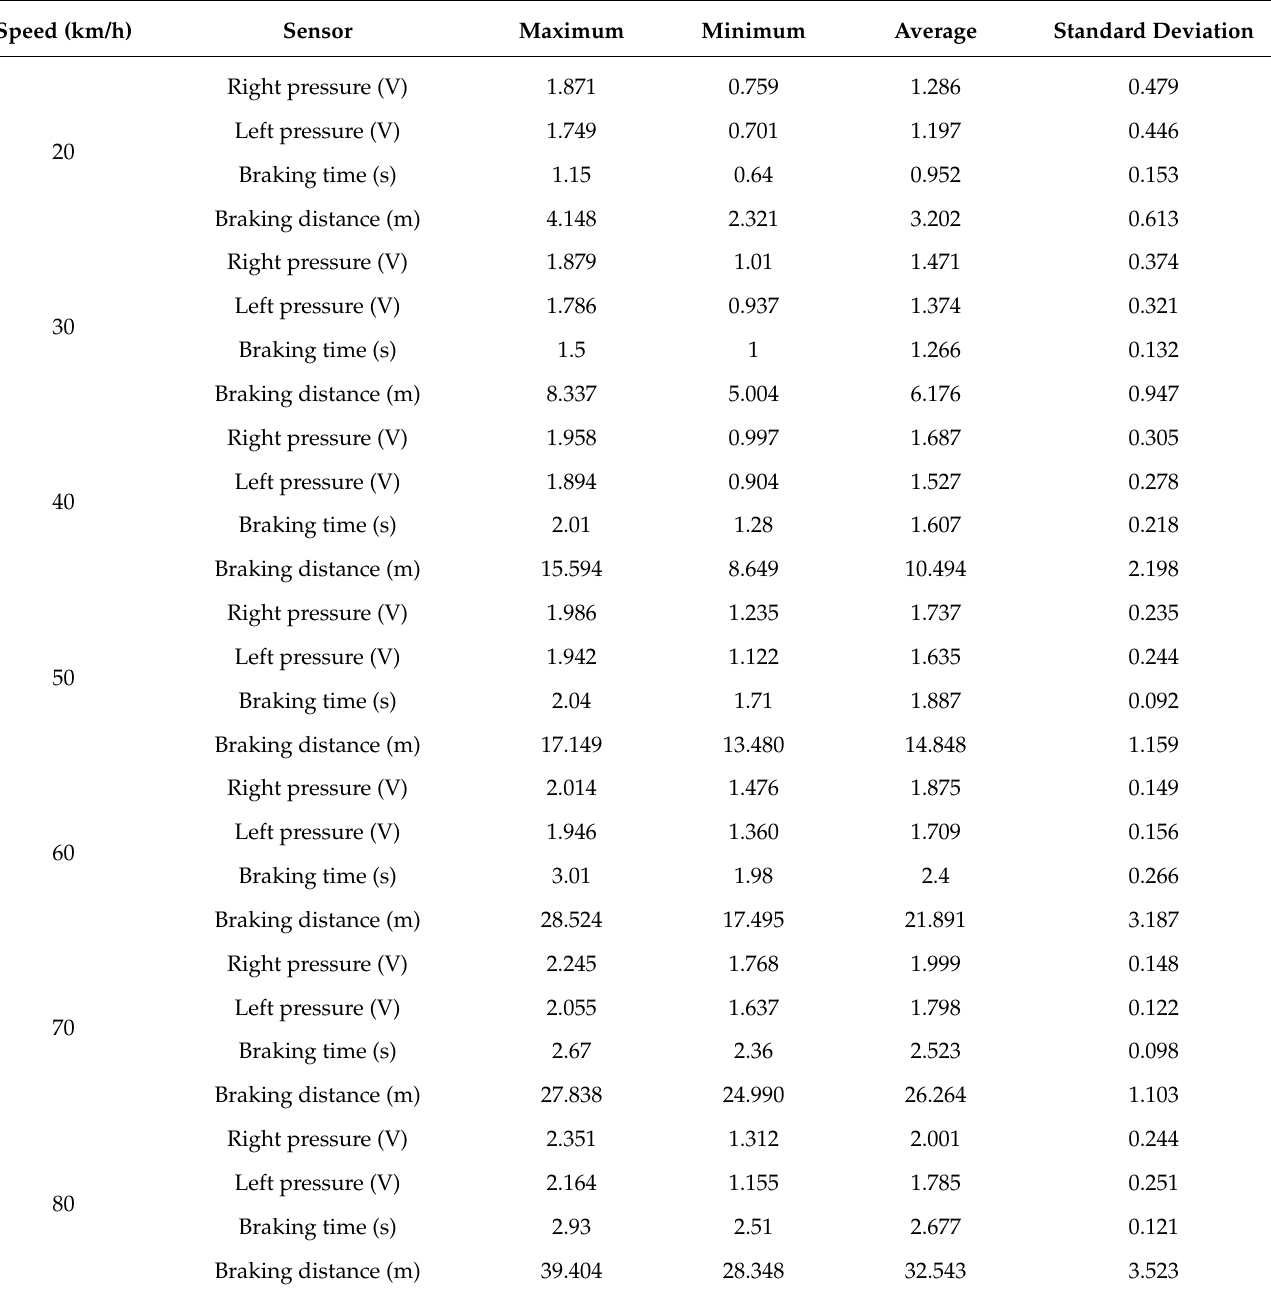
Table 4. Data from variables analysed for each test speed for emergency